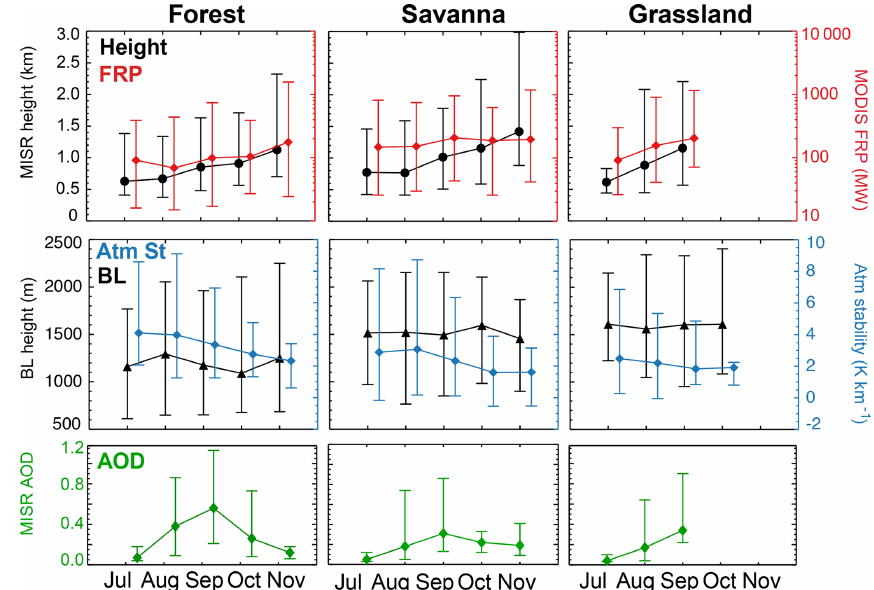
Figure 5. Seasonal cycle of MISR smoke plume maximum height above the terrain (black circles), MODIS FRP (red diamonds), PBL heights (black triangles), atmospheric stability (blue diamonds) and MISR AOD (green diamonds). Monthly median values are shown for tropical forest, savanna and grassland biomes. Vertical bars indicate the 10th and 90th percentiles. Distributions with fewer than 10 observations are omitted and all years are included.